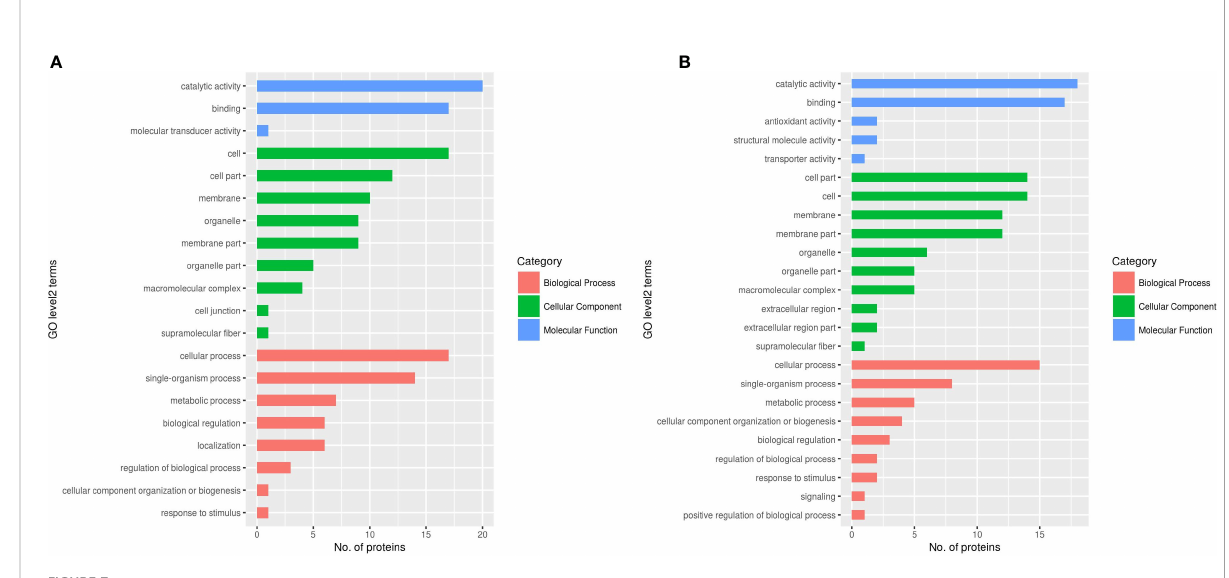
FIGURE 7 GO analysis of DEPs in female and male adult schistosomes. (A) Female; (B) Male.